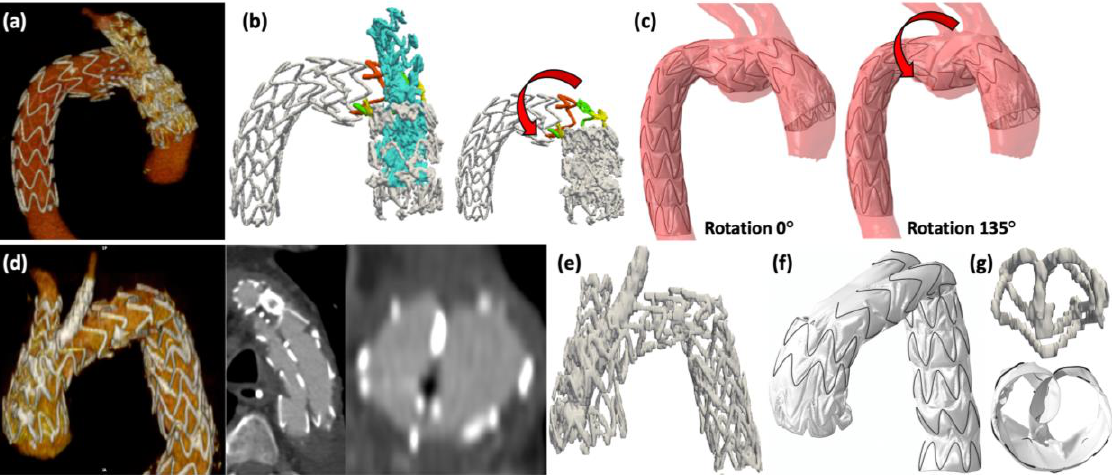
Figure 4. ( a ) 3-dimensional reconstruction of post-operative CT scan of case 2. ( b ) Stent-rings extracted from the post-operative CT scan: the half stent-rings of the fenestration zone are colored in yellow, green, and red and the bridging stents are colored in blue. The arrow indicates the torsion effect. ( c ) Simulation results with 0 ◦ and 135 ◦ rotation: torsion appearance and correct length are obtained with 135 ◦ rotation. ( d ) . 3-dimensional reconstruction of post-operative CT scan of case 3 and post-operative images showing the wrong expansion of the three stents located at the aortic isthmus level with infolding. ( e ) Stent-rings extracted from post-operative CT scan. ( f ) Coronal view of the simulation result. The arterial surface was omitted from the overview to facilitate visualization. ( g ) Cross-sectional views of the stent-rings extracted from post-operative CT scan (on top) and of the simulation result (at bottom) at the aortic isthmus level showing infolding.